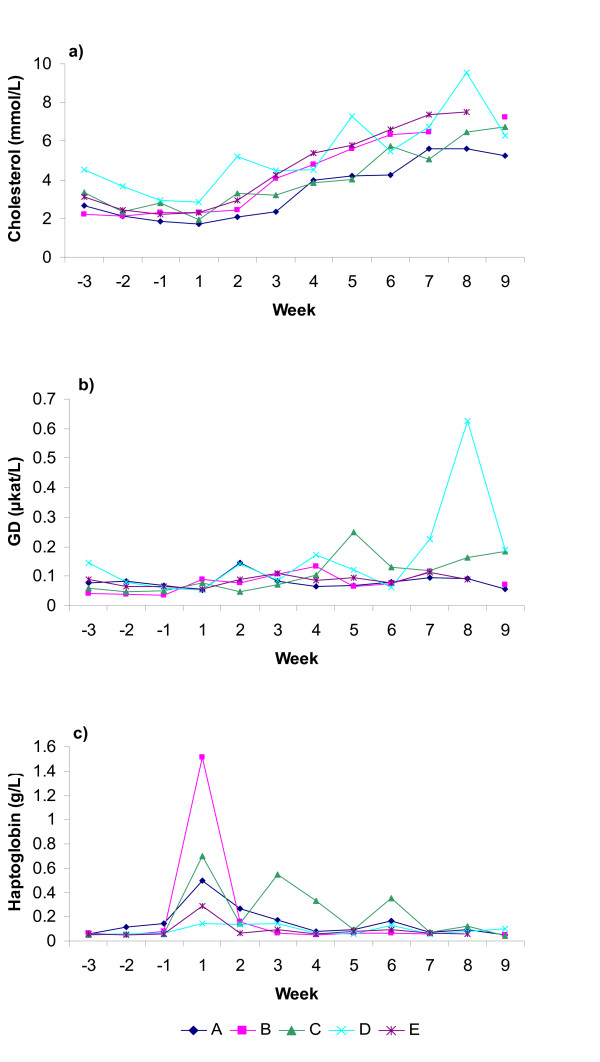
Herd-specific patterns for herd A-E shown as least-squares means. a) cholesterol, b) glutamate dehydrogenase (GD) and c) haptoglobin.